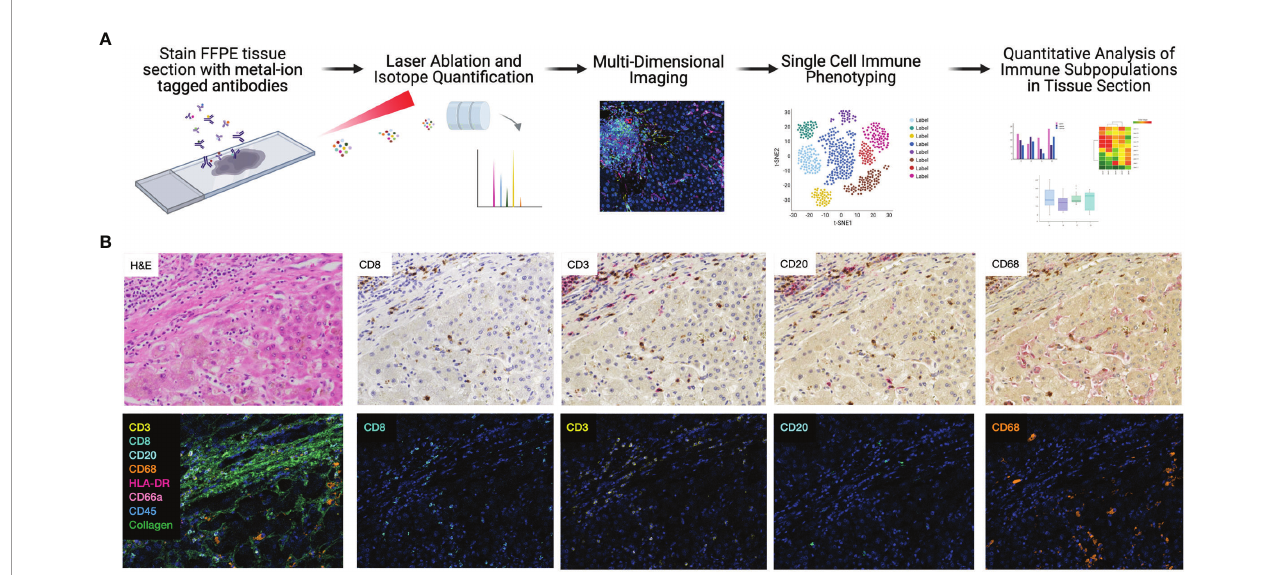
FIGURE 1 | Highly dimensional, single-cell immune phenotyping of human liver tissue with IMC. (A) Schematic of IMC data acquisition and analysis pipeline developed for this study. (B) Individual immune markers in FFPE clinical liver samples were examined using sequential immunohistochemistry (top panels; representative patient and subset of markers shown) and IMC (lower panels, adjacent tissue section from the same patient is shown to maintain morphological features).